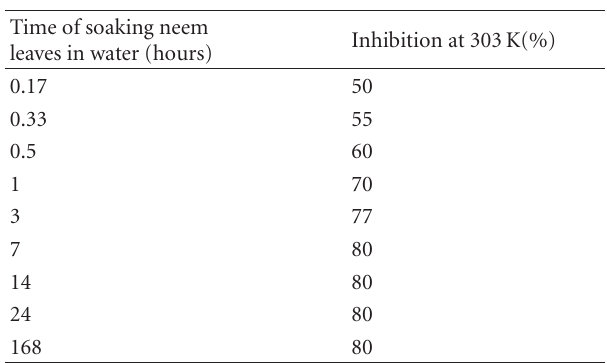
Table 1: The e ff ect of soaking time of Neem leaves in distilled water on the percentage inhibition.